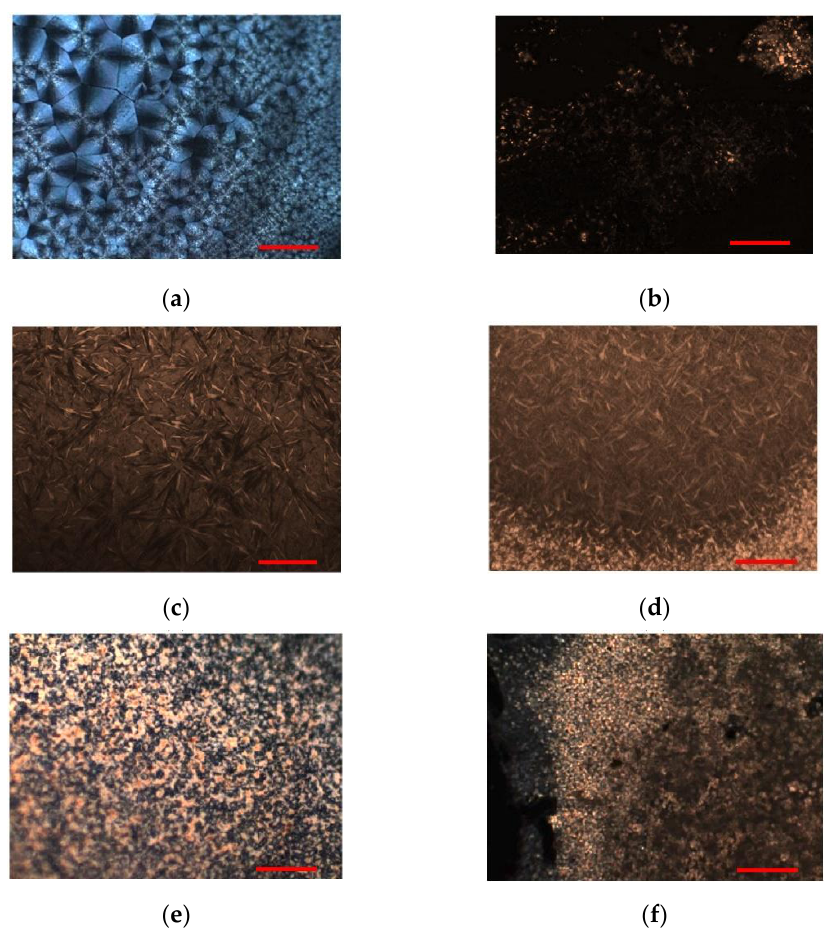
Figure 3. Optical micrographs of films before and after annealing for: TDOBSH ( a , b ); TDOBSNa ( c , d ); TDOBSPyr ( e , f ). The scalebar is 50 mkm.